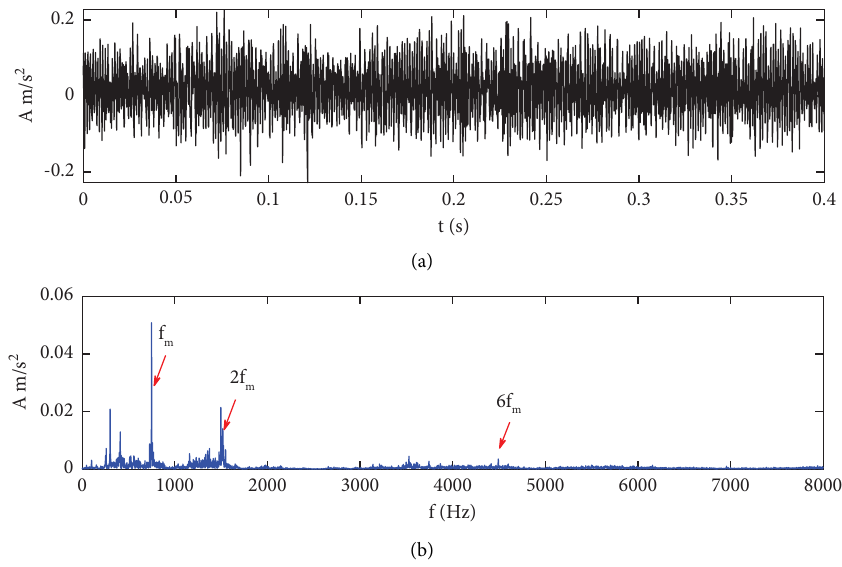
Figure 21: Responses of driving bearing node: (a) the time domain; (b) the frequency domain.